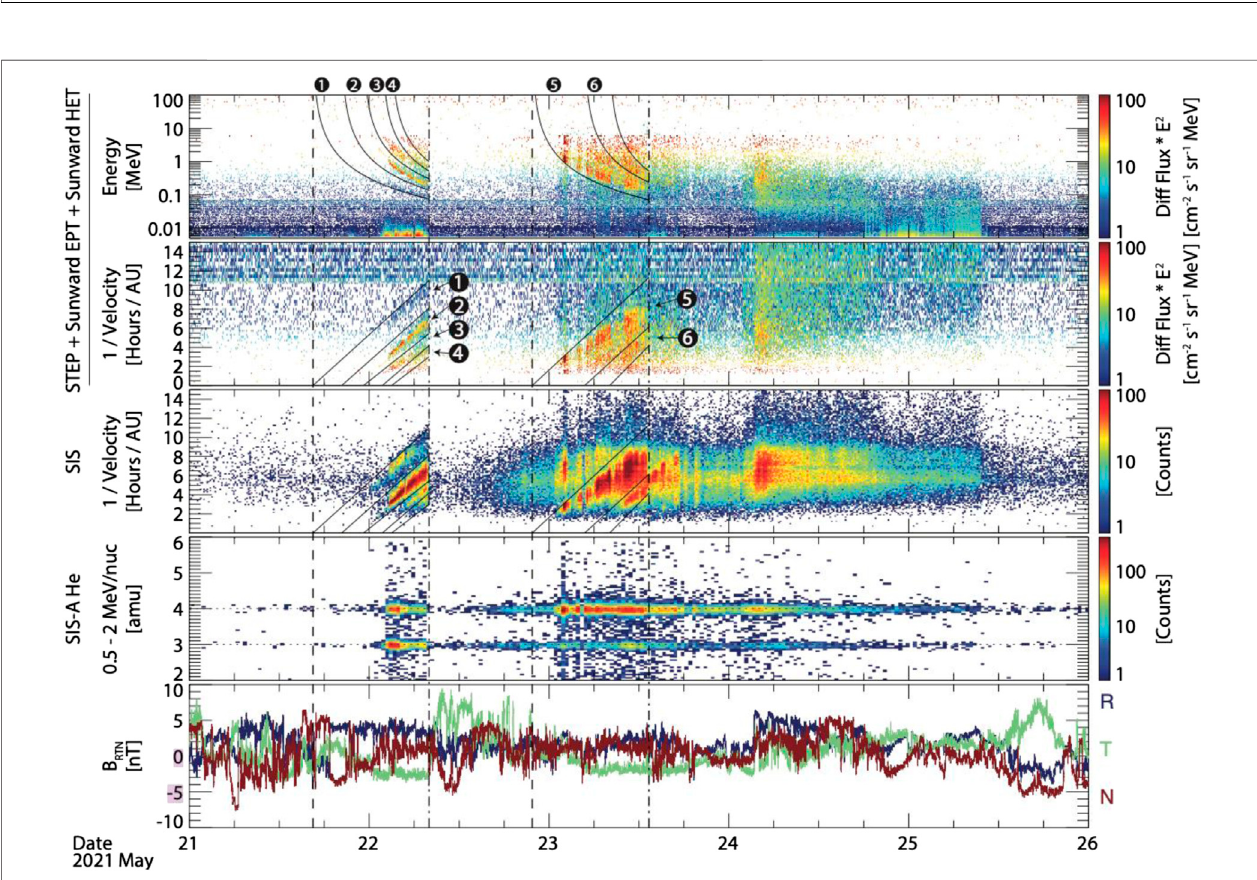
FIGURE 2 | Overview of the Solar Orbiter observations from May 21-25, 2021. The top panel shows the total ion energy measurement; second panel shows the total ion inverse velocity; third panel shows the SIS inverse velocity measurement of heavy ions (C-Fe); the fourth panel shows the SIS mass spectrogram for helium isotopes; and the last panel shows the interplanetary magnetic fi eld (IMF) in RTN coordinates. The six 3 He-rich events are labeled 1-6.